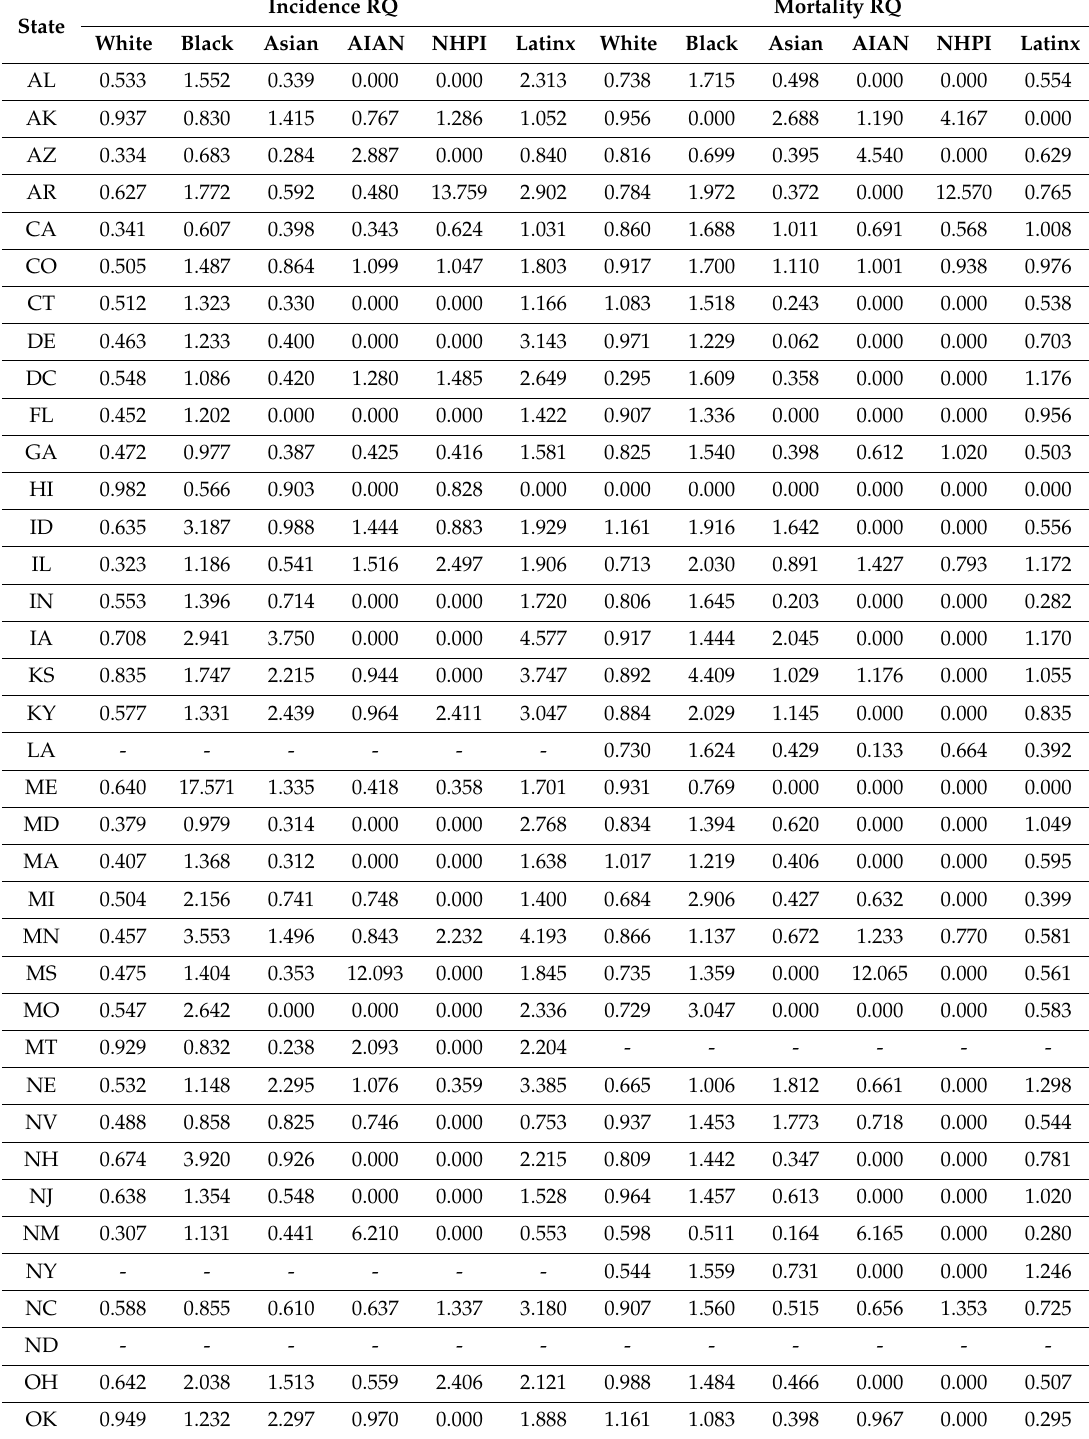
Table A1. Racial / Ethnic Representation Quotients of COVID-19 Outcomes by